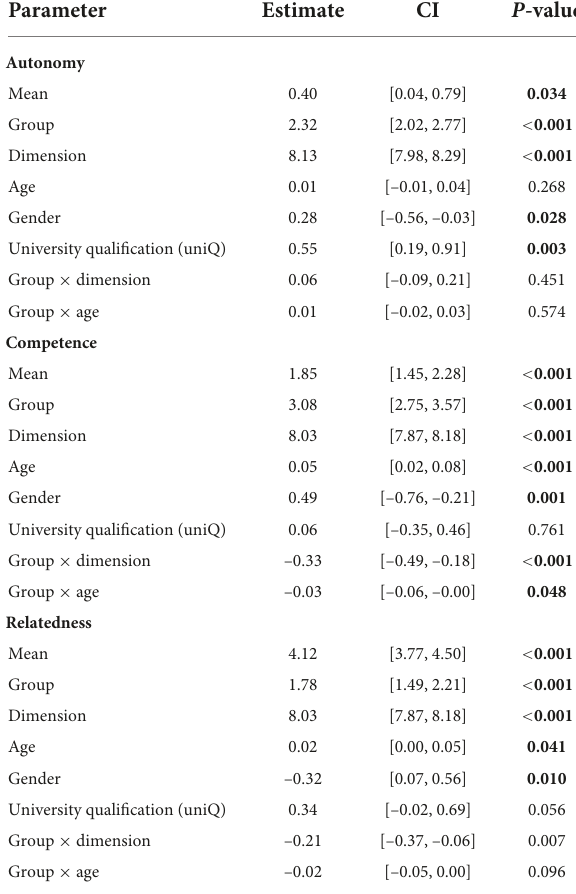
TABLE 3 Fixed-effect estimates of three linear mixed models for each score of the basic psychological needs (Autonomy, Competence, Relatedness) including effects of the group (depressed vs. non-depressed), the dimension (satisfaction vs. frustration), as well as their interactions and covariate effects (age, gender, and university